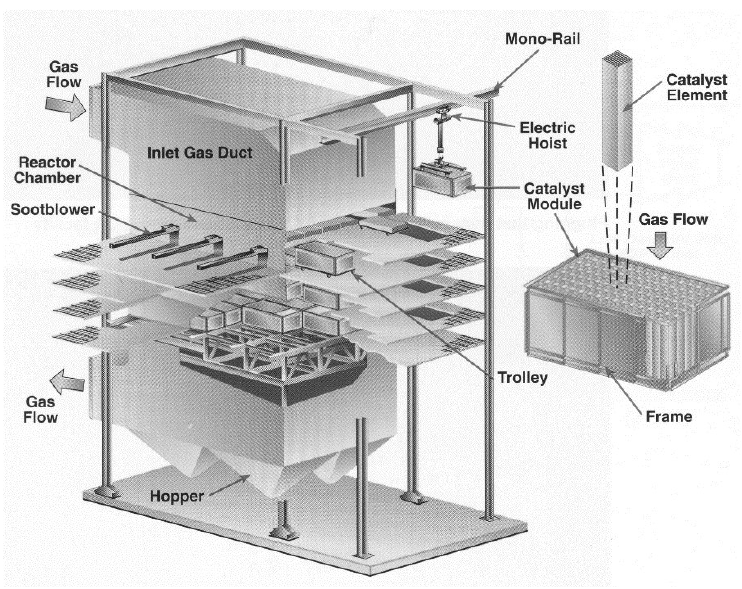
Figure 41. Vertical-flow fixed-bed SCR reactor. DOE SCR demonstration facility at Gulf Power Company’s Plant Crist. Reproduced from [313].